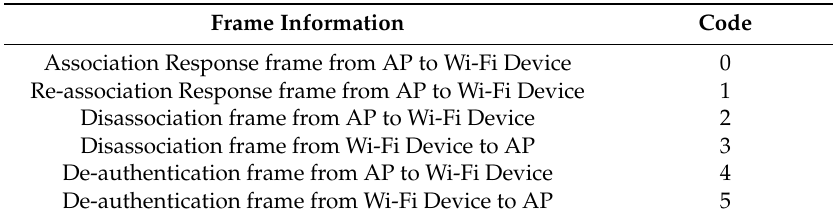
Figure 9. Frame type and transmission direction. Table 4. Frame Information Encoding.